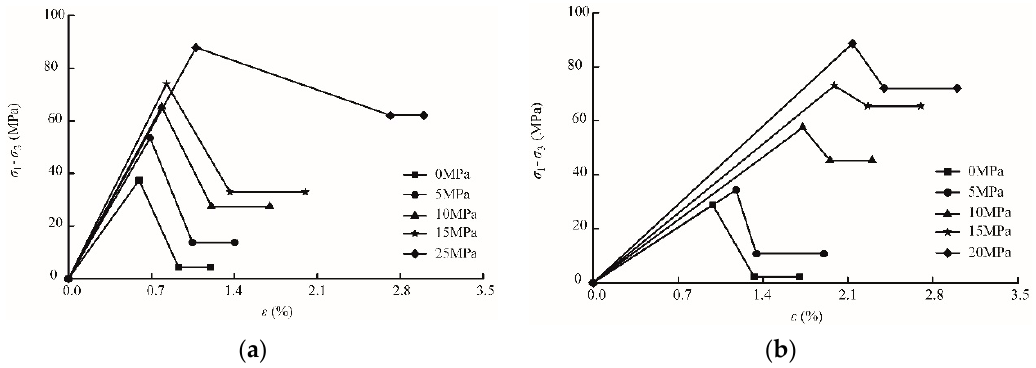
Figure 11. Simpli fi ed stress ‒ strain curve: ( a ) sandstone; ( b ) mudstone. According to the above method, the 𝜀 (cid:3045)(cid:3032)(cid:3046)(cid:3036)(cid:3031)(cid:3048)(cid:3028)(cid:3039)(cid:3043) − 𝜎 (cid:2871) relationship curves of all the over- lying strata can be obtained (Figure 12).